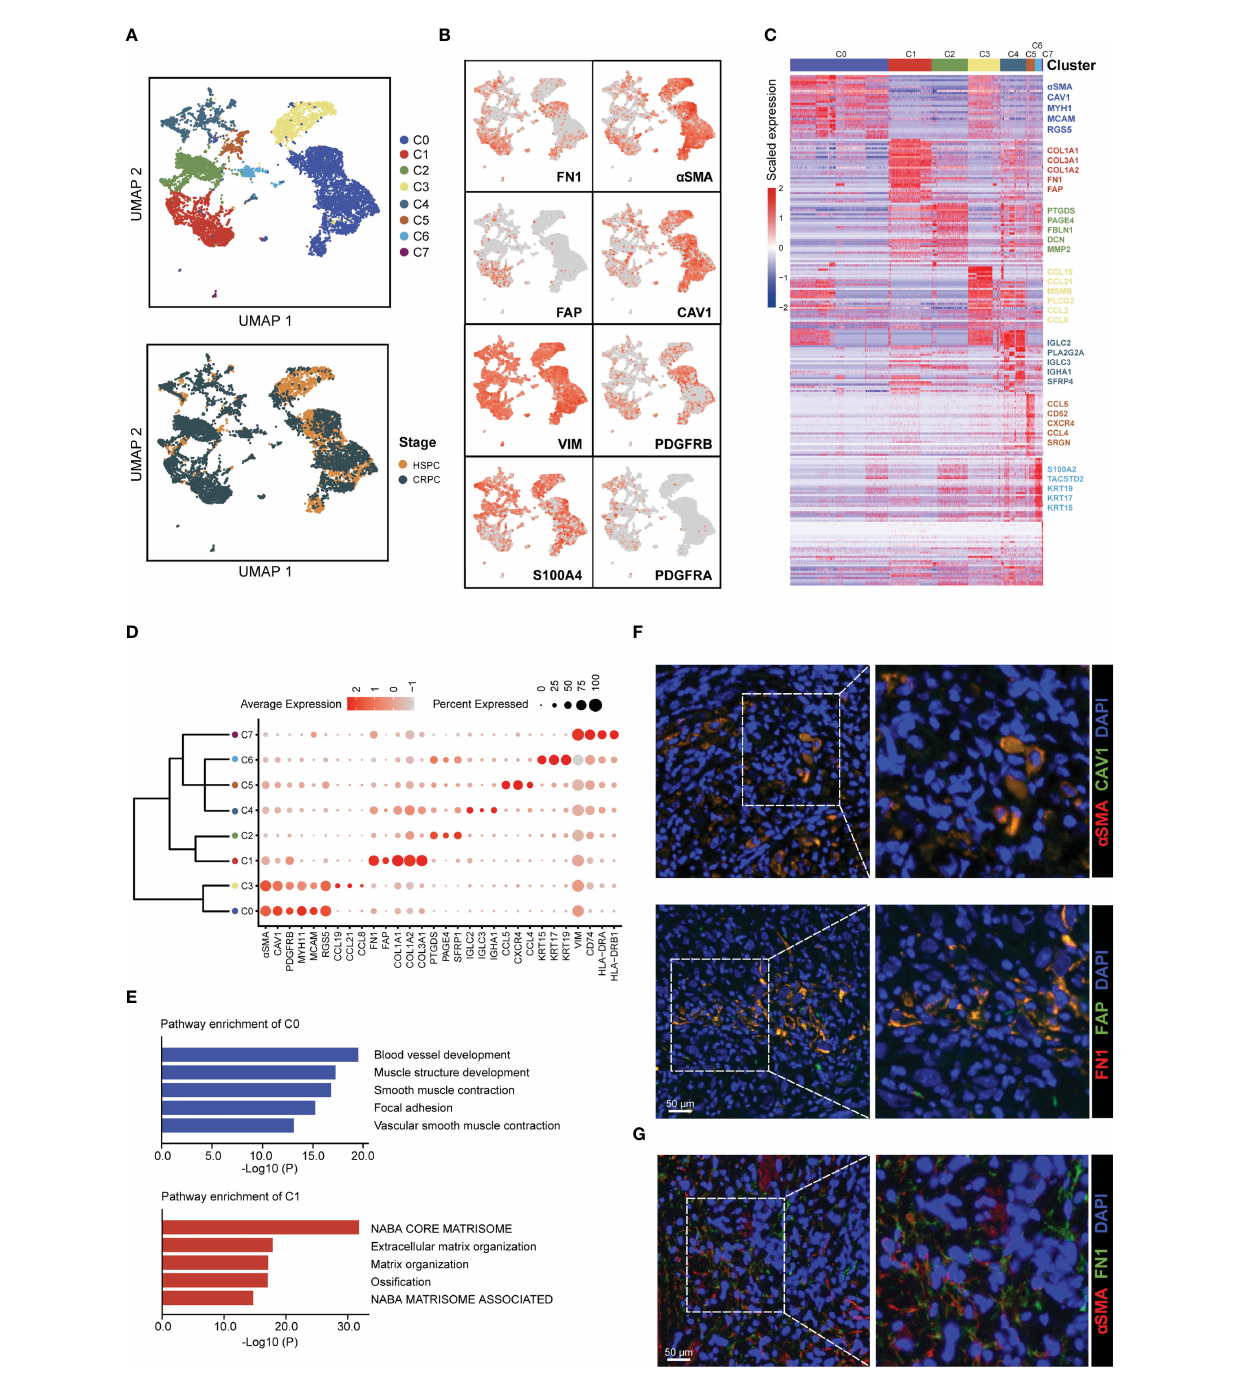
FIGURE 1 Identi fi cation of CAFs subtypes in prostate cancer microenvironment. (A) UMAP plot of CAFs colored by subtypes (top) and tumor stages (bottom), with 4,584 fi broblasts from HSPC samples and 3,732 fi broblasts from CRPC samples. (B) UMAP plot showing the expression levels of fi broblasts marker genes. (C) Heatmap showing the DEGs between different CAFs subtypes. (D) Dot plot displaying the expression levels of representative CAFs subtype-marker genes. (E) Top 5 enriched pathways for CAFs-C0 and CAFs-C1. (F) Representative fl uorescence images of a SMA + CAV1 + (top) and FN1 + FAP + CAFs (bottom) from prostate cancer samples. Scale bar, 50 m m. (G) Representative fl uorescence image of a SMA and FAP-stained prostate cancer samples. Scale bar, 50 m